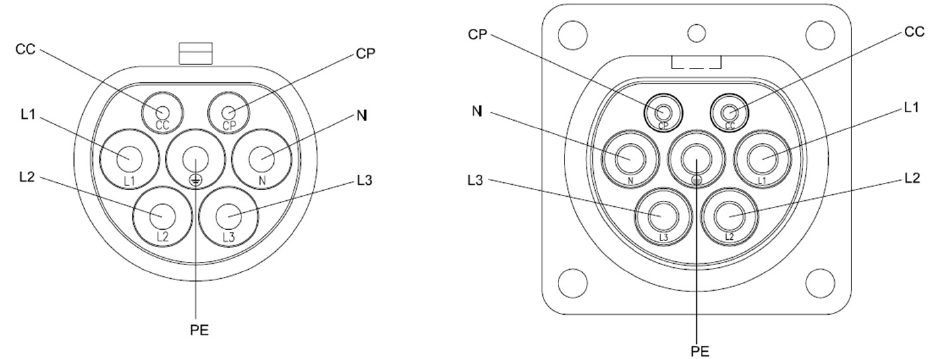
Figure 22. The GB/T AC Coupler pinout: EV Plug ( Left ) and Inlet ( Right ).